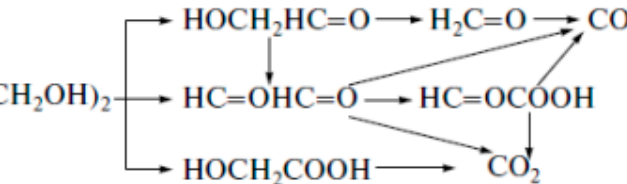
Figure 13. Base directions of EG transformation. Reprinted with permission from reference [88]. Copyright 2013 Springer.